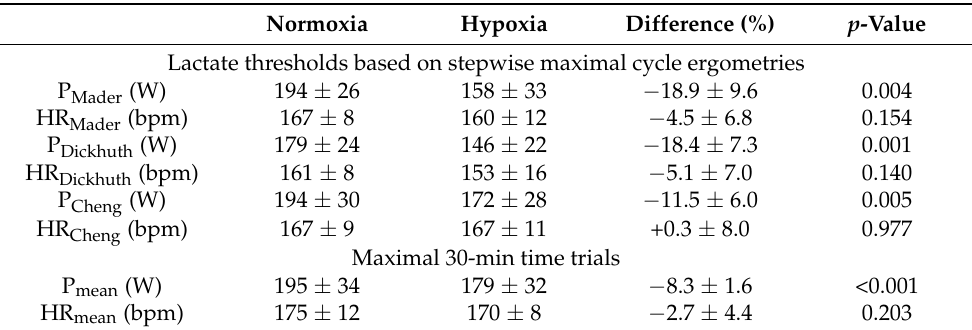
Table 1. Power output and heart rate at different lactate thresholds and during maximal 30-min time trials in normoxia and hypoxia. Values are means ± SD. p -Values refer to a comparison of normoxia and